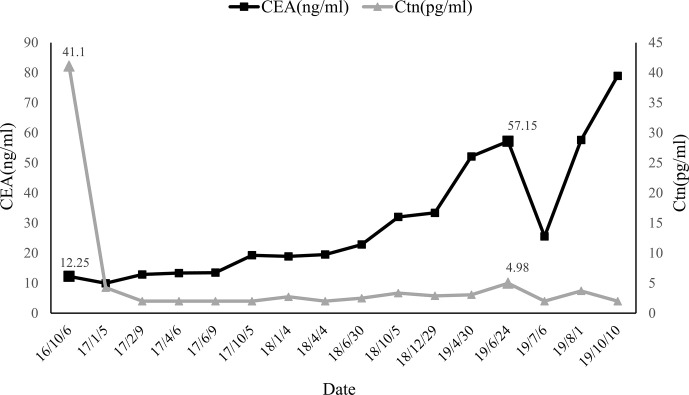
Changes in CEA and Ctn of serum levels from the fisrt operation to the last follow-up.